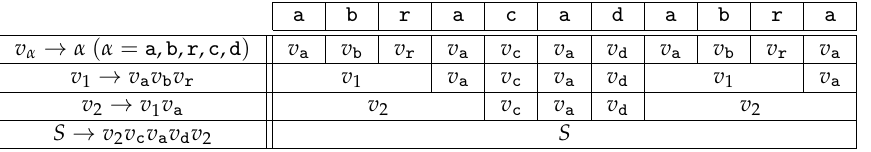
Figure 3. An example of the grammar generation process of MR-RePair for the text abracadabra . The generated grammar is